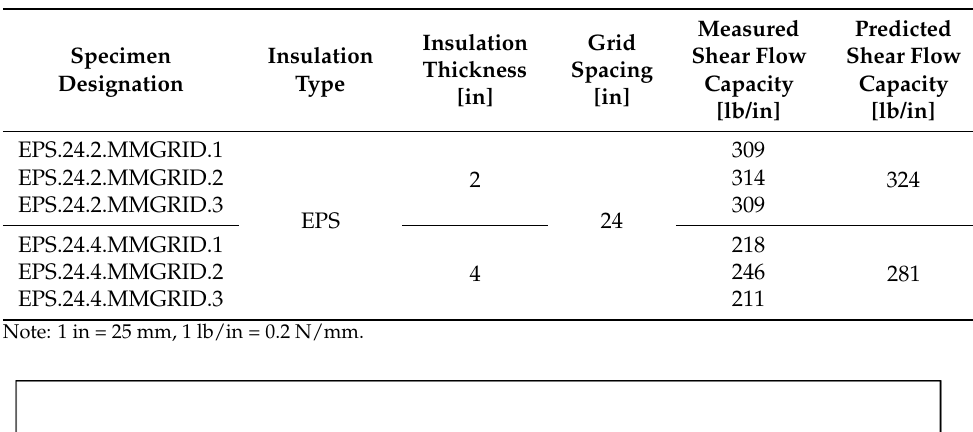
Table 5. Comparison of measured and estimated mean shear flow capacities.